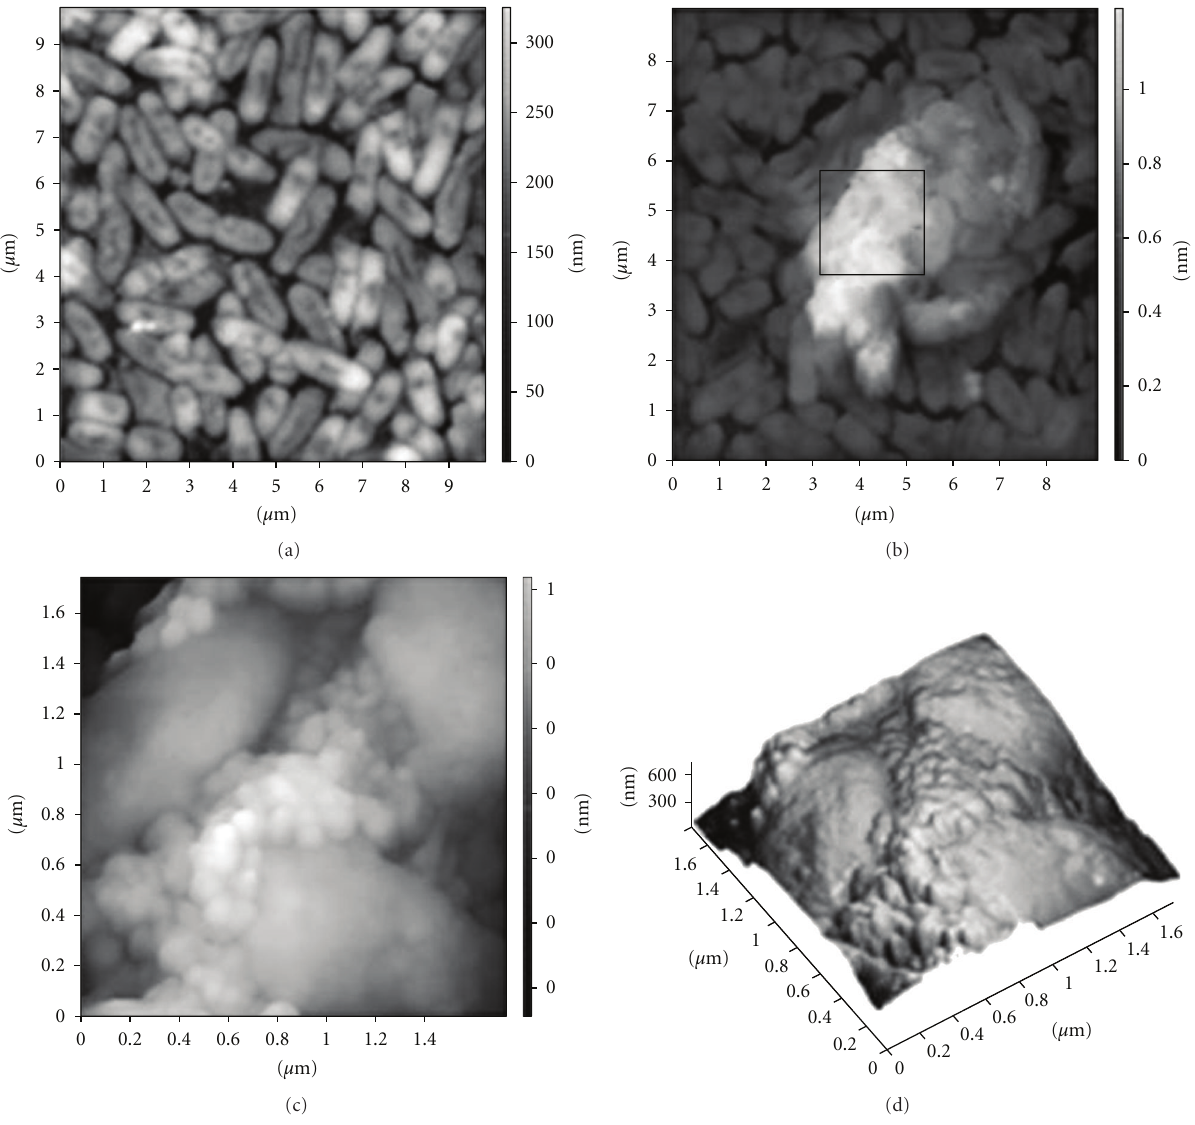
Figure 5: Atomic force microscopy images of Pseudomonas aeruginosa ATCC 15692 colonizing single wall carbon nanotube-coated glass bead (SWCNT-GB). (a) SWCNT-GB colonization by Pseudomonas aeruginosa ATCC 15692 after three hours of incubation (adherent bacteria); (b): SWCNT-GB colonization by P. aeruginosa ATCC 15692 after 24 hours of incubation (biofilm); (c) higher magnification of delimited area in (b) showing extracellular matrix between bacterial cells; (d) three-dimensional view of the same area of